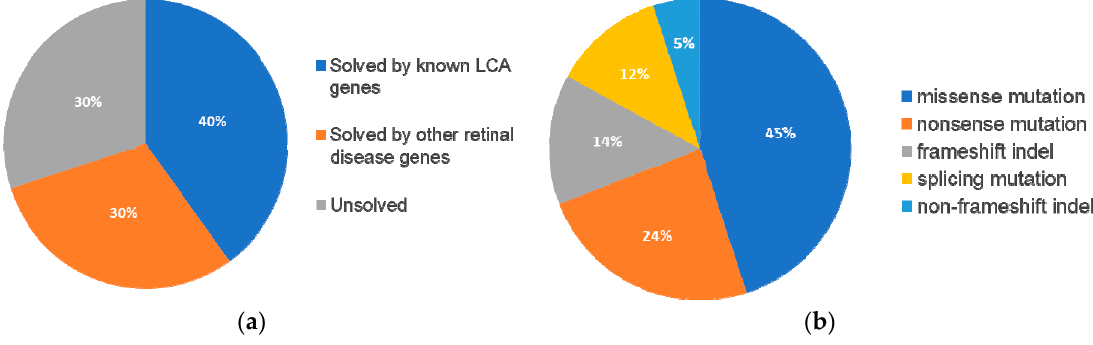
Figure 1. Breakdown across 43 probands with pathogenic variants in known retinal disease genes and the respective type classification for these mutations. ( A ) 17 (40%) individuals were solved by pathogenic variants in known Leber Congenital Amaurosis (LCA)-associated genes while 13 (30%) of individuals were solved by pathogenic variants in genes not typically associated with LCA. 13 (30%) of individuals were not identified to contain likely pathogenic mutations in known retinal disease genes. ( B ) The percentage of each classification type of mutation across the 42 pathogenic variants identified in the 30 solved cases.